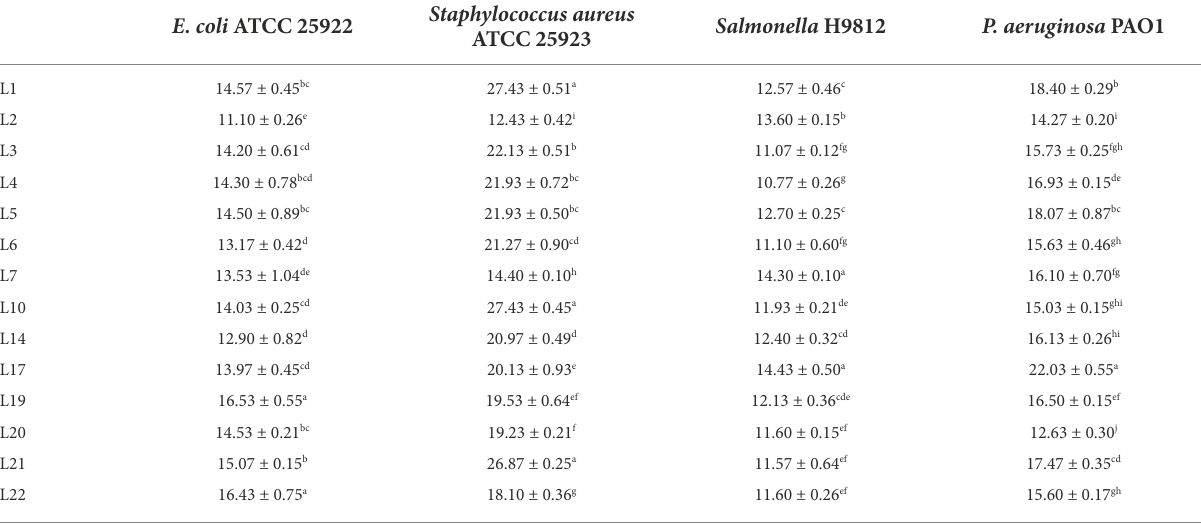
TABLE 1 Antagonistic activity of potential probiotic isolates from cow milk samples against four target pathogenic bacteria by the Oxford cup method. 1 Strain